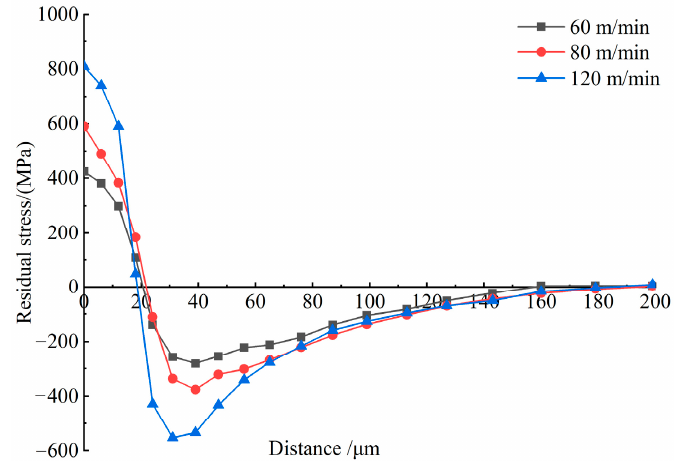
Figure 6. Residual stress distribution in cutting simulation.